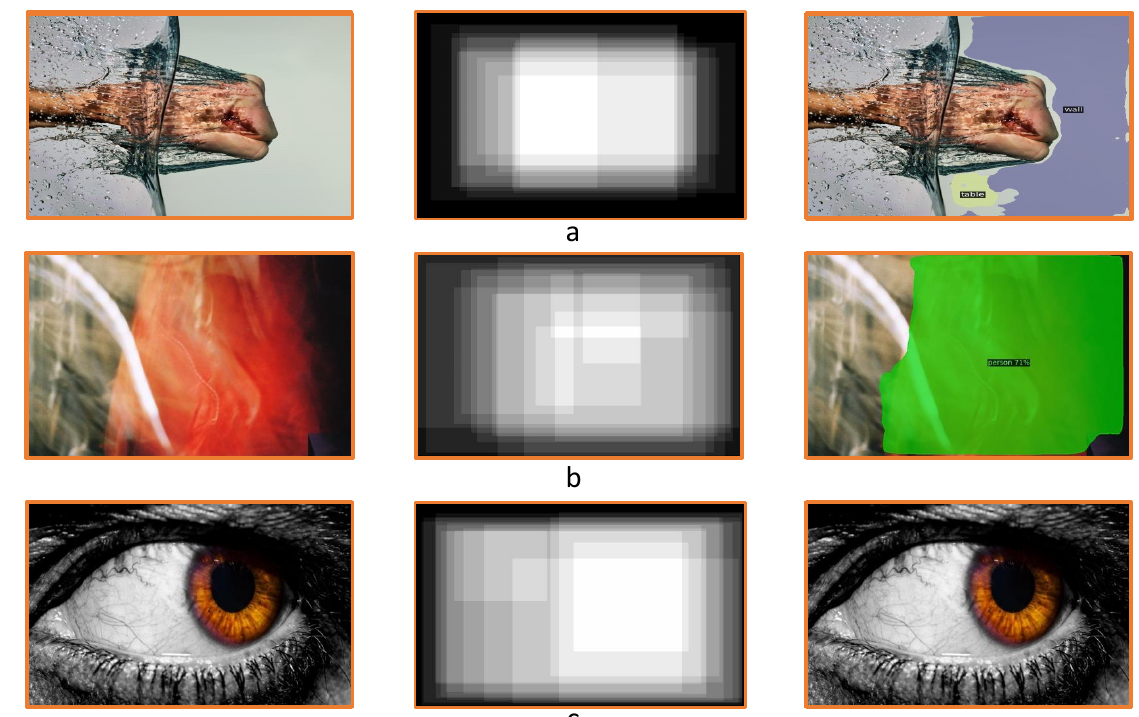
Figure 7. Some example images and corresponding Emotion Stimuli Maps whose object information is broken extracted by panoptic segmentation model, but correctly predicted by our method. The lefts of ( a – c ) are the raw images, the middles are the corresponding stimuli map and the rights are the visual results of